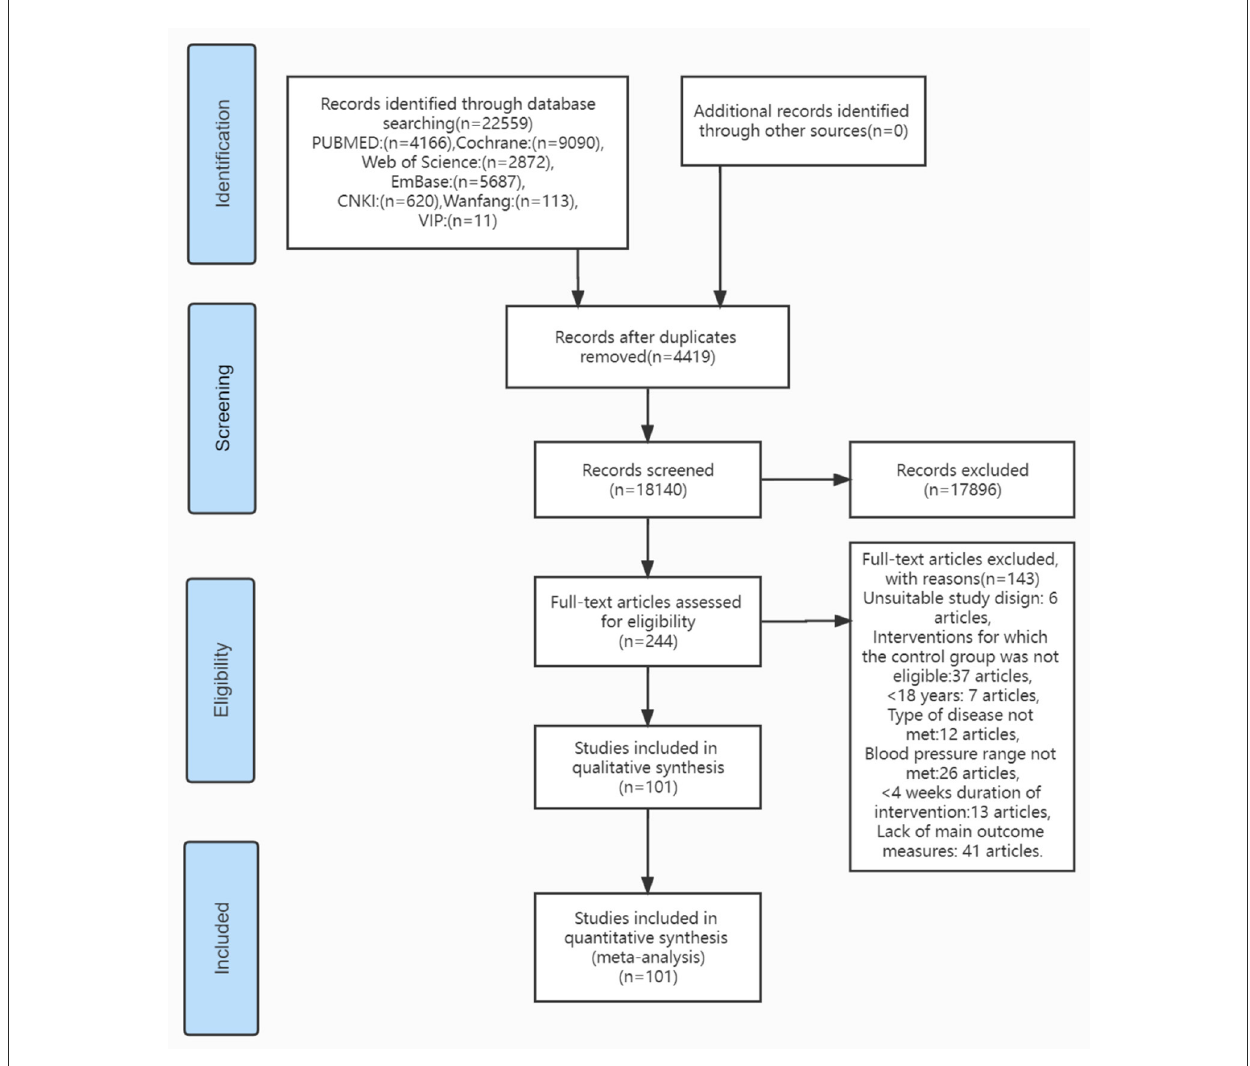
FIGURE1 Database search and selection